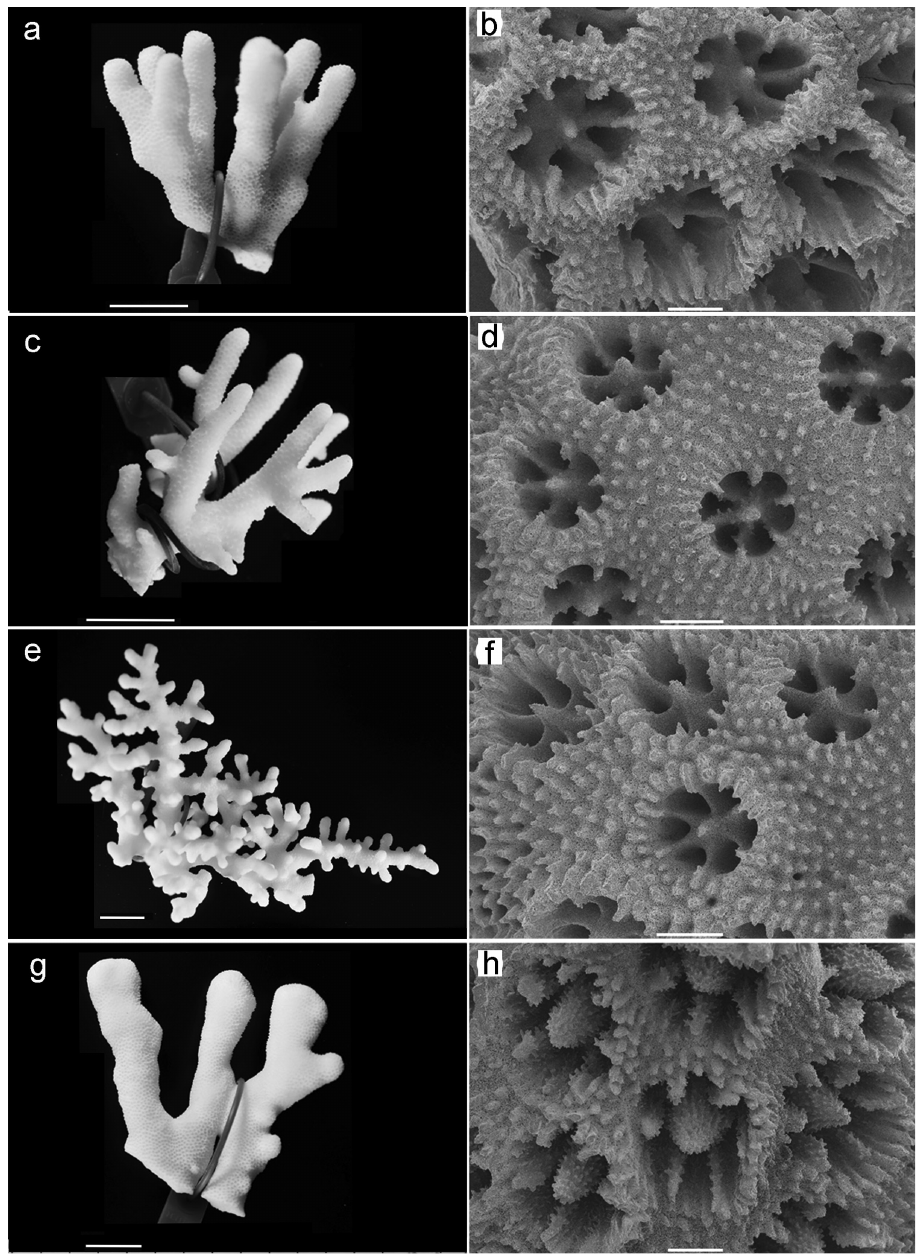
Figure 2. Stylophora pistillata , coral skeletons and corallite structures (SEM). a, b Specimen SA13-12 c, d Morphotype subseriata , specimen SA13-25 e, f Morphotype danae SA13-31 g, h Morphotype mor- dax , specimen SA13-61. Scale bars: 20 mm ( a, c, e, g ); 0.5 mm ( b, d, f, h )